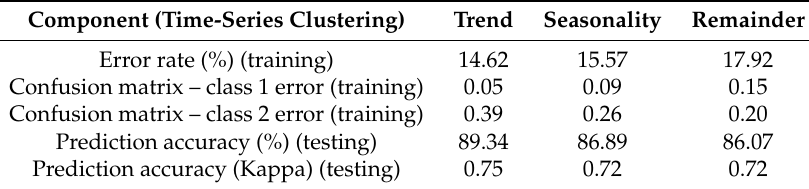
Table 3. Random forest model assessment for each time-series clustering map as the response variable.